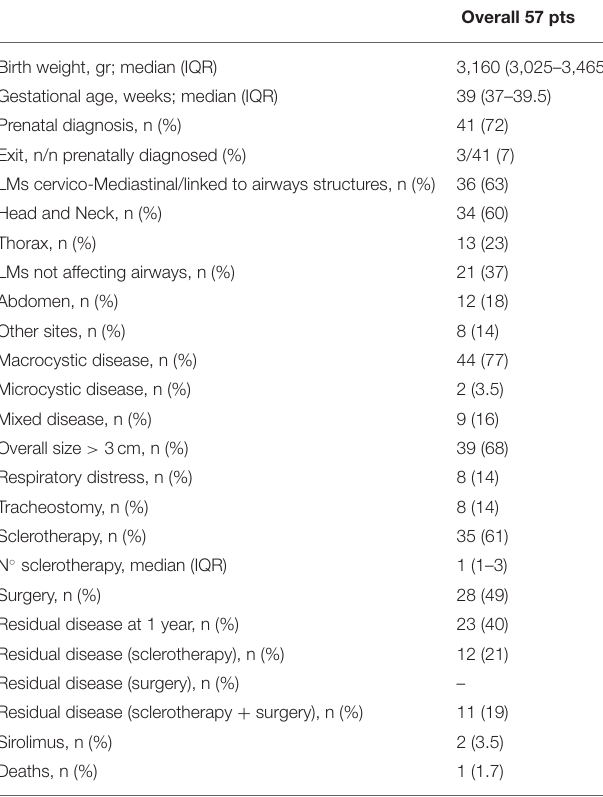
TABLE 1 | Overall demographics, clinical characteristics, and treatment options. TABLE 2 | Comparison on demographics, clinical characteristics, and treatment options between patients with or without respiratory distress (group A and group B,